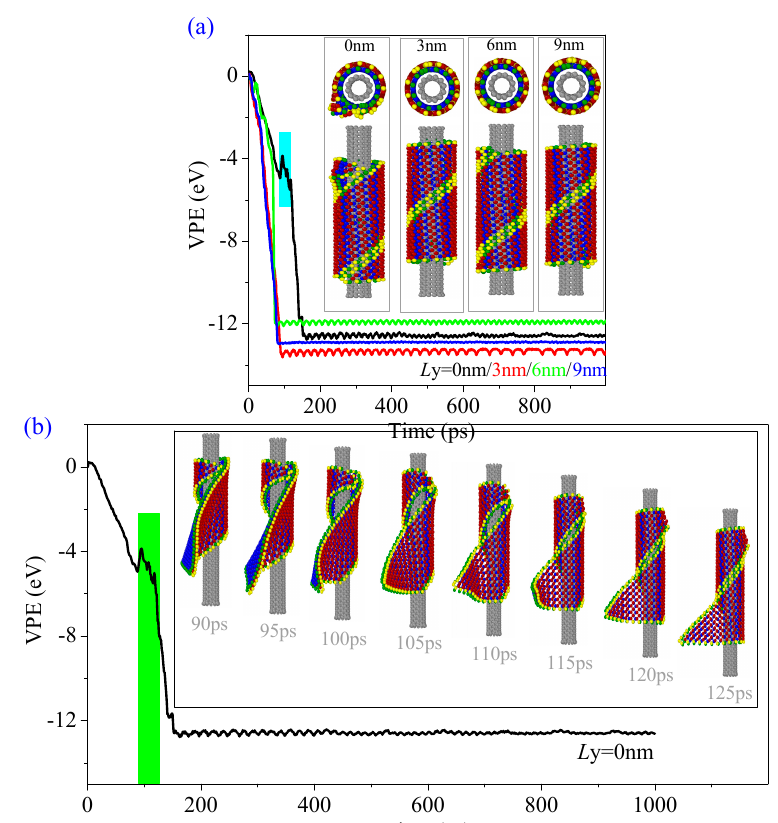
Figure 2. Historical curves of the variation of potential energy (VPE) of the BP during winding upon the CNT (6, 6) with α = 0 ◦ at 14 K. ( a ) VPE curves of the BP with different values of L y. Snapshots of the final state of the BP ribbon are inserted. ( b ) Winding process of the BP ribbon on the CNT with L y = 0 nm.